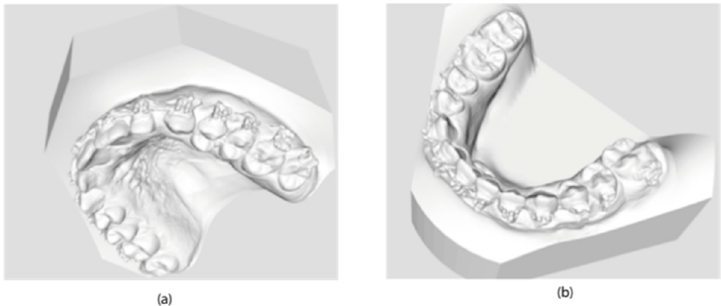
Figure 1. Scanning of stone dental models: ( a ) upper jaw; ( b ) lower jaw.